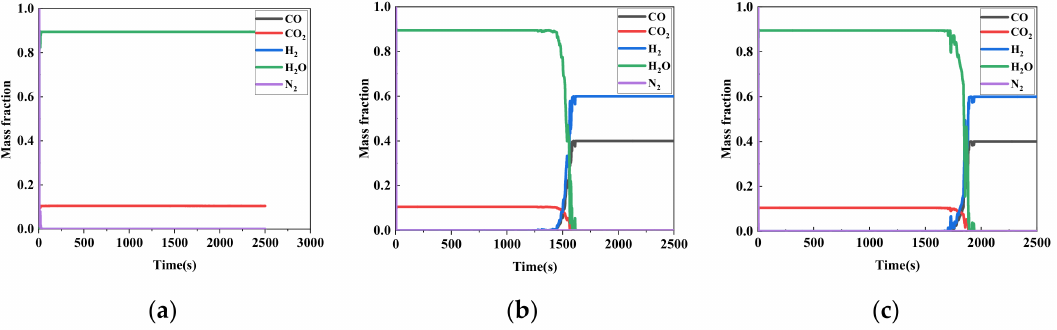
Figure 13. Changes in gas composition over time. ( a ) Experiments 19. ( b ) Experiments 20. ( c ) Experiments 21.